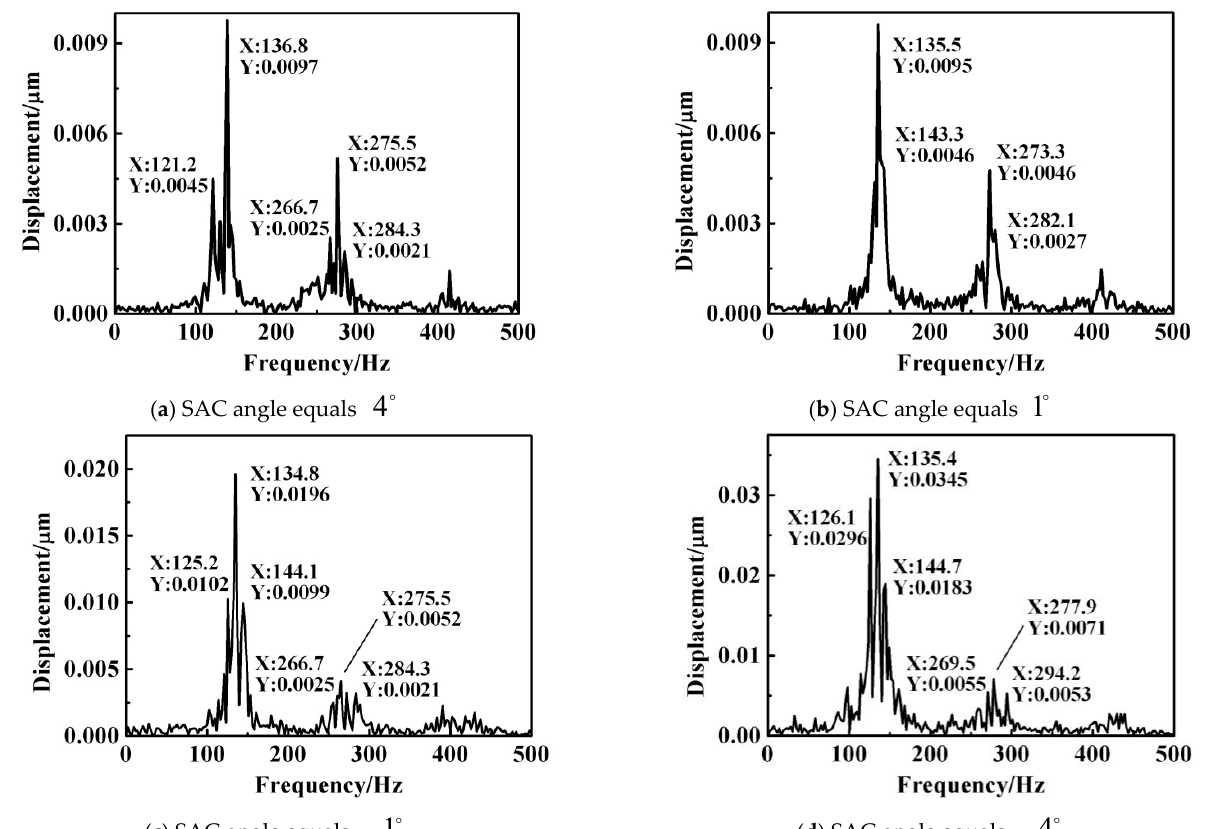
Figure 16. The displacement spectrum of the inner ring in Y direction with different SAC angles.